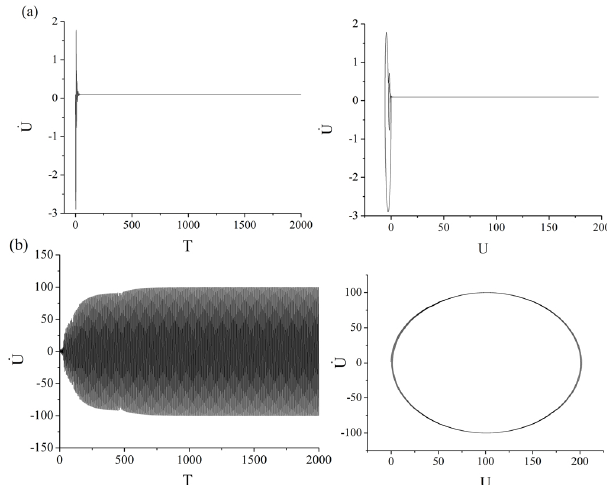
Fig. 3. Temporal behaviour of variable ˙ U and corresponding phase portraits for: (a) equilibrium state (point 1 from Fig. 2; ν c = 7, τ = 3, c = 3) and (b) periodic behaviour (point 2 from Fig. 2; ν c = 7, τ = 4, c = 3). The phase portrait in (b) is obtained having eliminated the